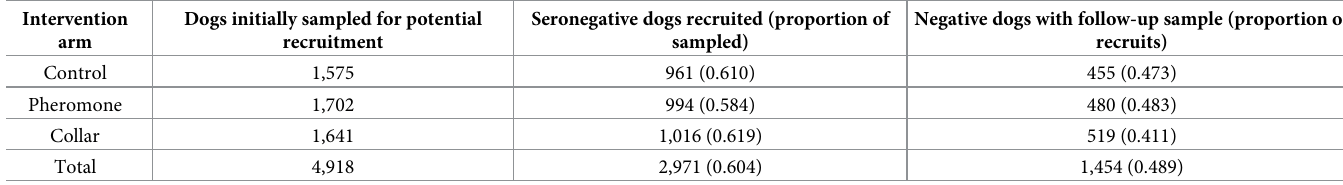
Table 2. Summary of the total dogs sampled, recruited and with follow-up sample, according to the trial intervention arm to which the dogs were subsequently allocated. Intervention Dogs initially sampled for potential arm recruitment